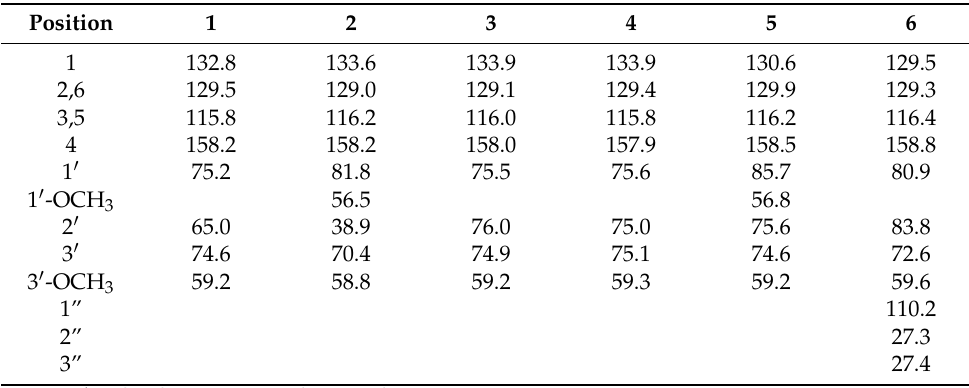
Table 2. 13 C-NMR spectroscopic data for compounds 1 –